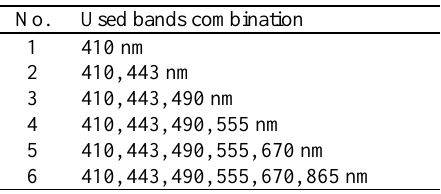
Table 1. Number of used bands combination for sensitivity study of ALH with the multi-viewing intensity and polarization measurements